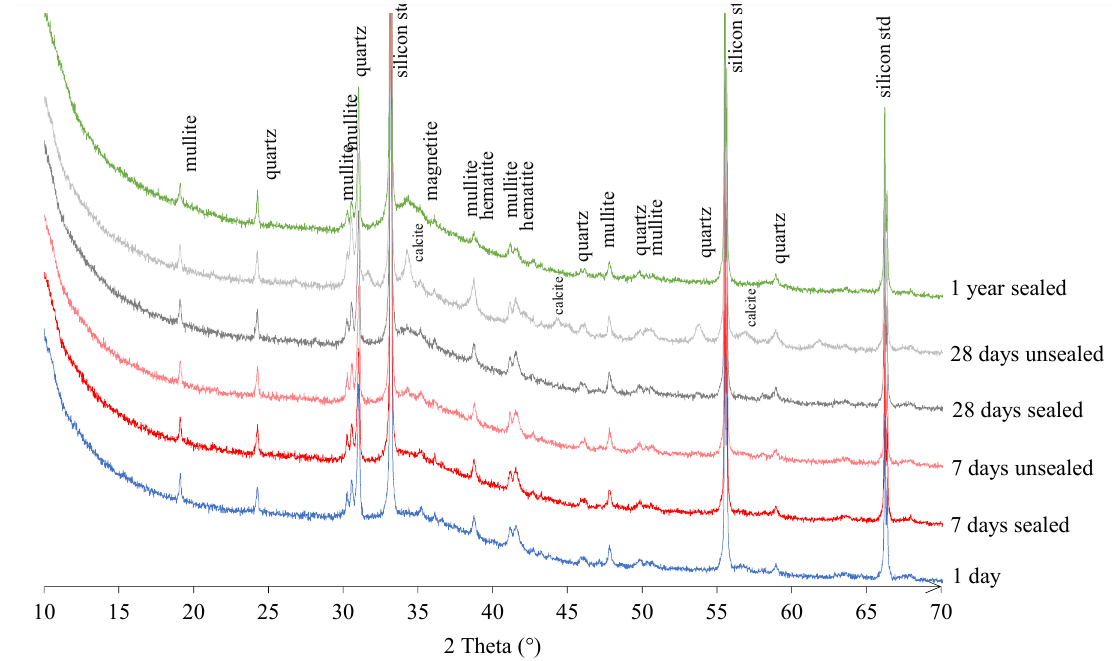
Figure 23. XRD diffractograms showing the phases in paste S50 for sealed and unsealed curing conditions.